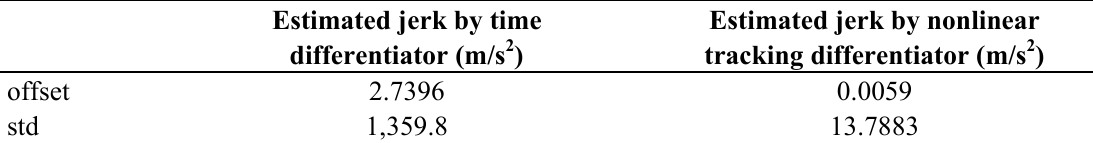
Table 2. Offset and noise standard deviation of estimated jerk in high dynamic condition with the two